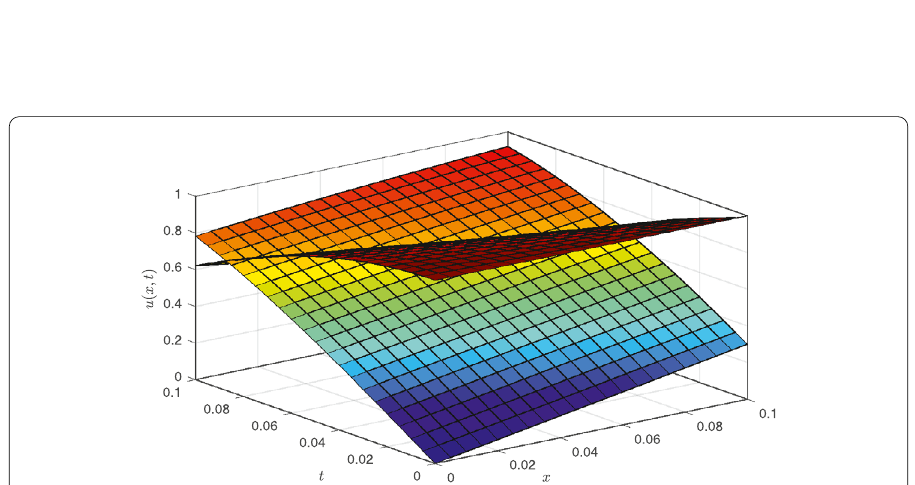
Figure 9 The approximate solution of Example 2 for Case 1 and α = β = 0.5